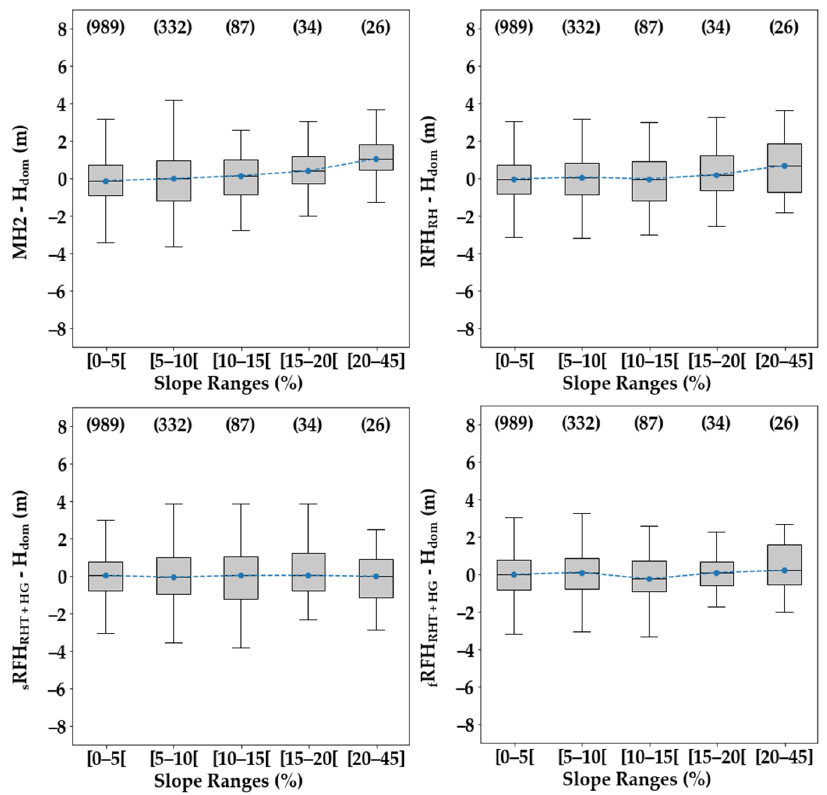
Figure 8. Box-whiskers plots of the difference between estimated and in situ H dom using four estimation models across five slope ranges. Numbers in parenthesis represent the number of points in each slope